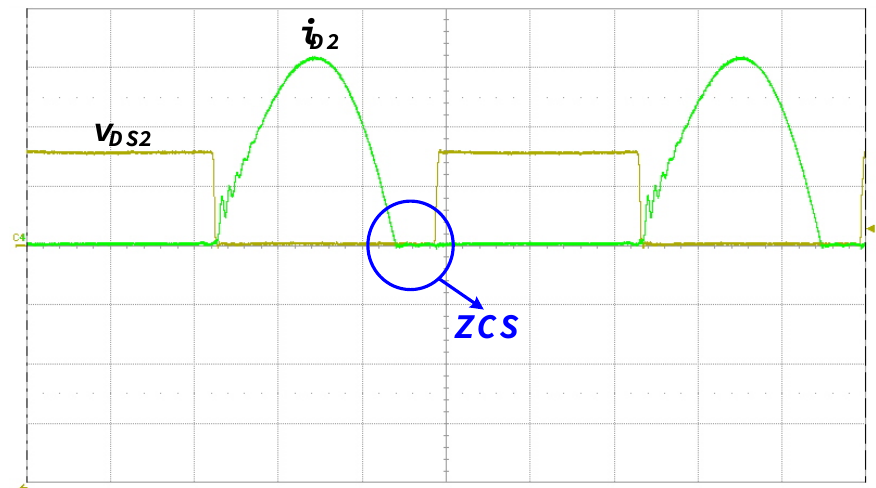
Figure 11. Measured switch voltage v DS 2 (200 V/div) and current i D2 (2 A/div) of the output rectified diode D 4 ; time scale: 2 μs/div.